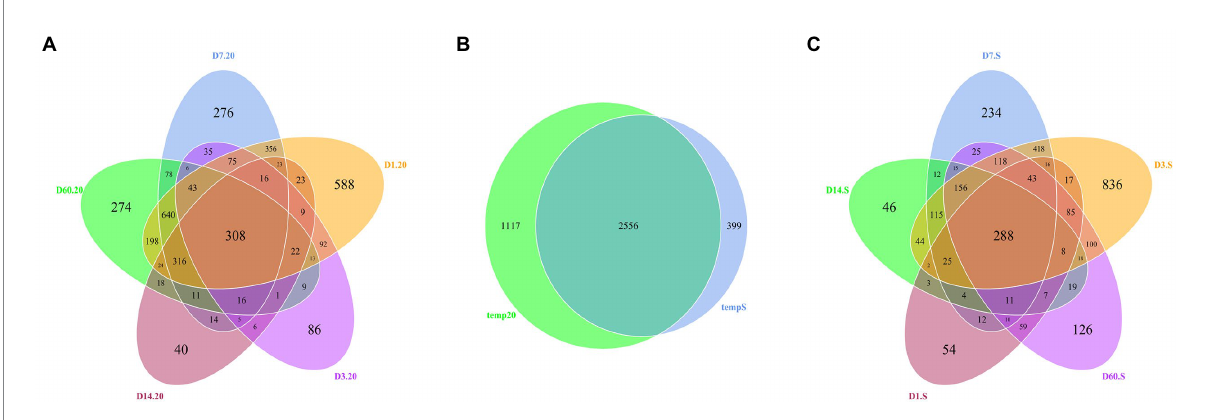
FIGURE 4 Venn diagram of core OTUs in: (A) fresh, 1, 3, 7, 14, and 60 days samples stored at 20 ° C; (B) the 20 group and S group; and (C) fresh, 1-, 3-, 7-, 14-, and 60-day samples stored under freeze–thaw condition. 20, constant temperature of 20 ° C; and S, freeze–thaw condition, alternating 20 and − 5 ° C every 12